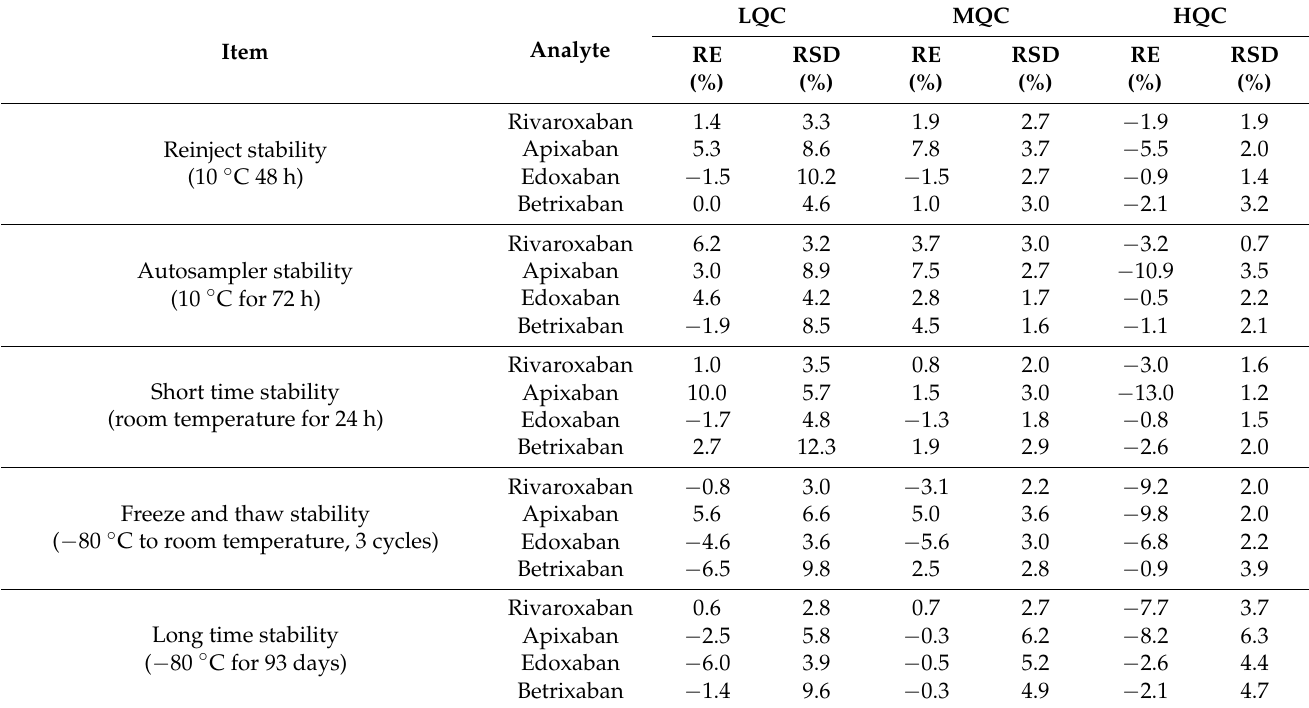
Table 7. Stability of all analytes under different conditions in